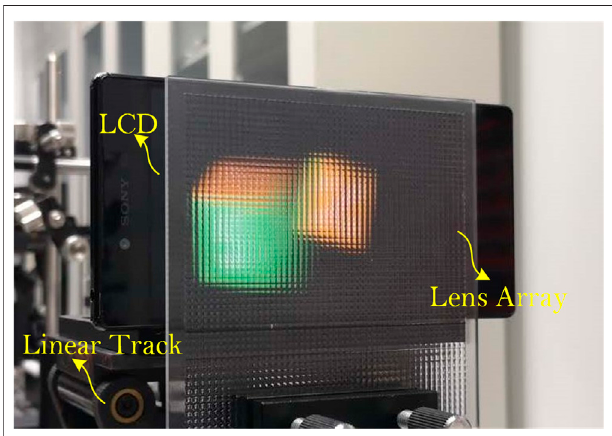
FIGURE 7 | The display system used in the experiments.